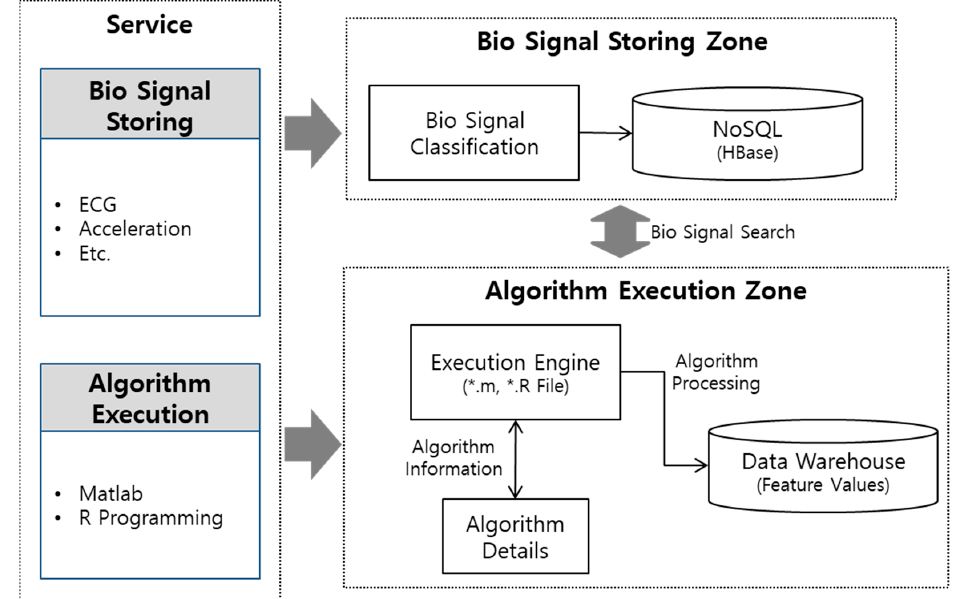
Figure 1. Architecture for analyzing bio-signal data by MATLAB and R